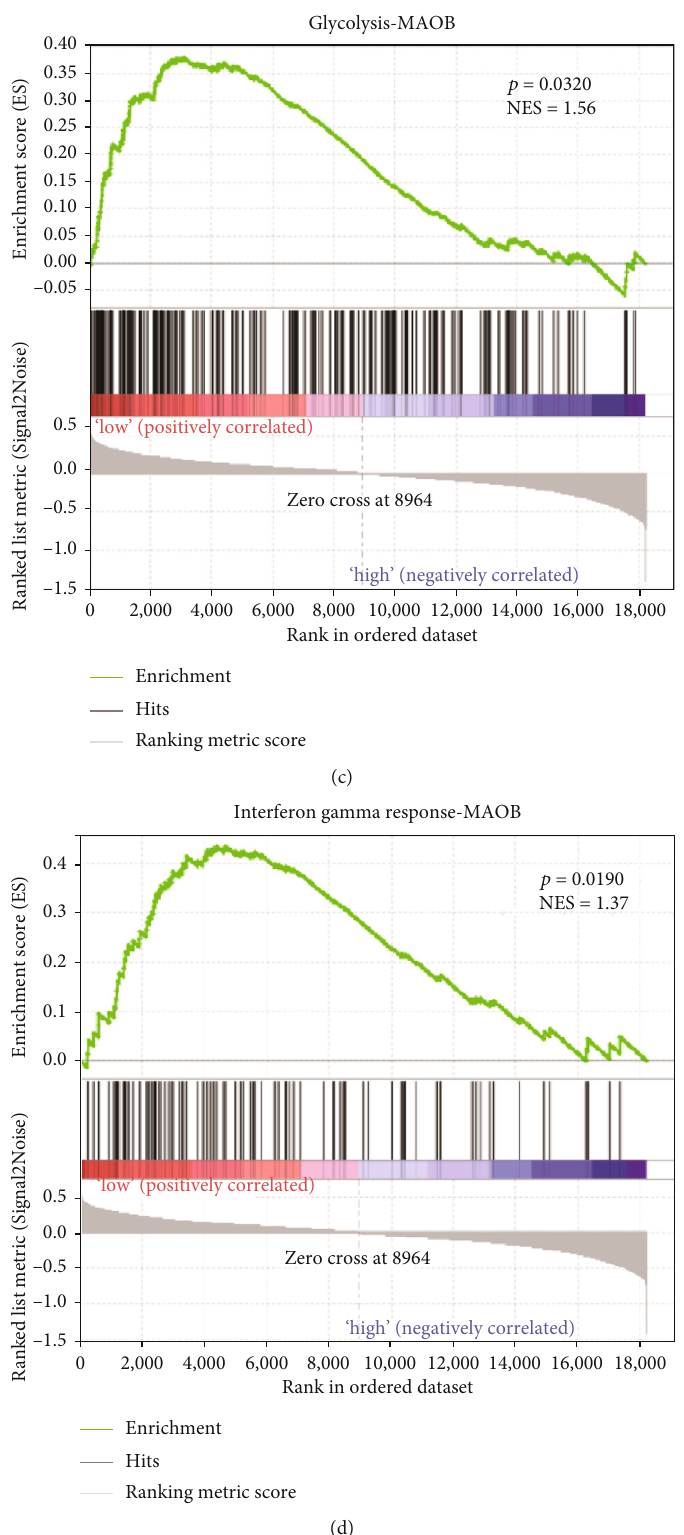
Figure 3: The expression levels of both MAOA and MAOB show a negative correlation with the glycolysis pathway. For the immune-related interferon gamma signaling pathway, the expression levels of both MAOA and MAOB showed a negative